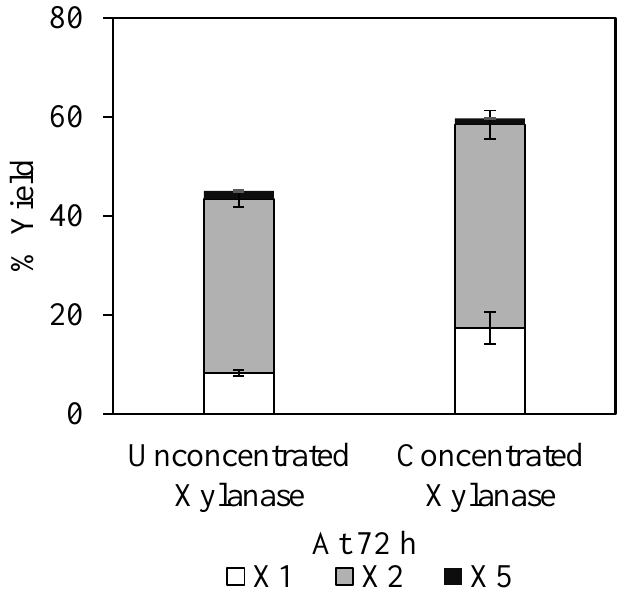
Figure 2. The yield from primary hydrolysis using alkali-pretreated EFB from either unconcentrated or concentrated XYN10Ks_480 endoxylanase produced by recombinant S. lividans 1326 in 72 h. X1, xylose; X2, xylobiose; X5, xylopentaose. 229